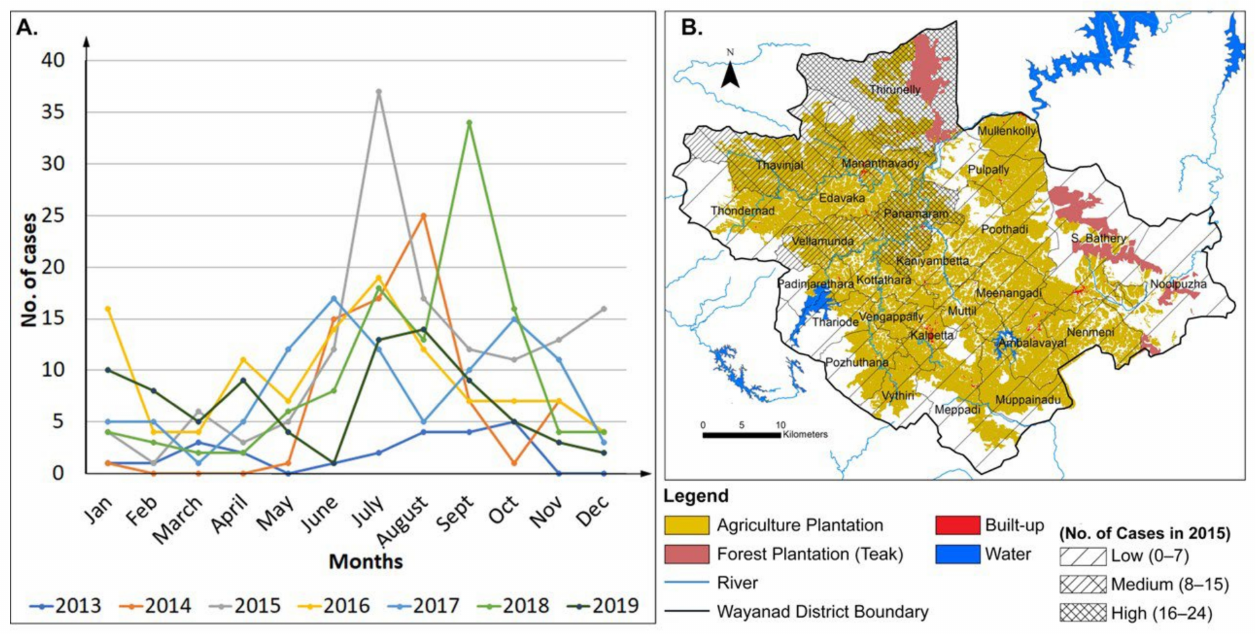
Figure 6. ( A ) Month-wise Leptospirosis cases in Wayanad district. ( B ) Correlation between LULCC of Wayanad and Leptospirosis